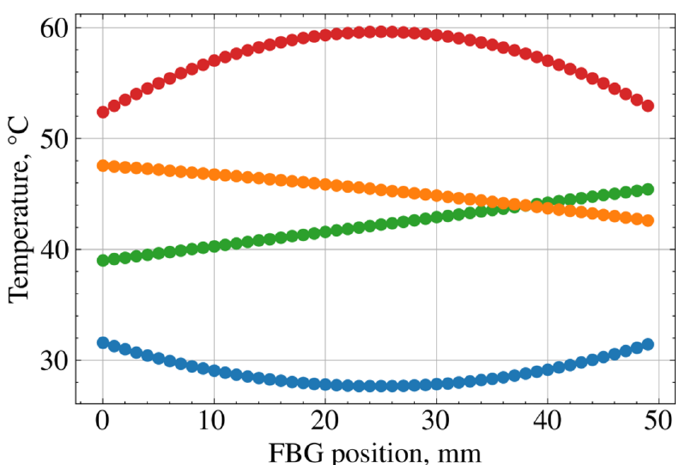
Figure 4. Examples of exploited temperature gradients during training procedure.